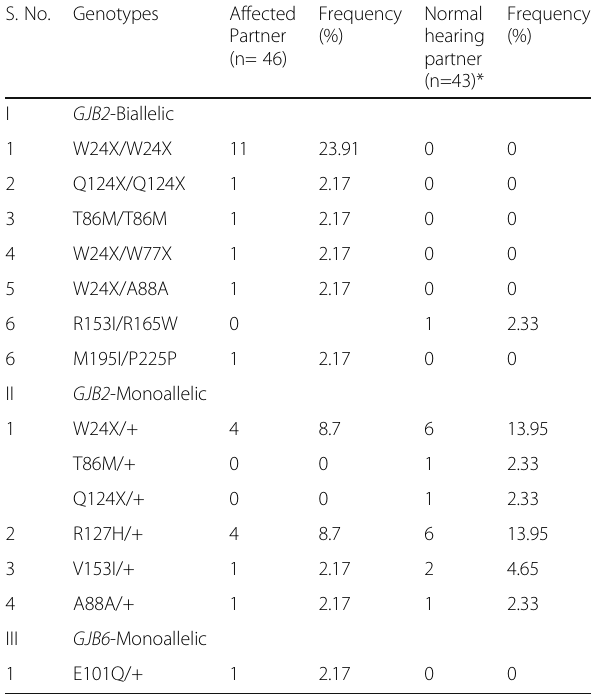
Table 9 Frequency and distribution of GJB2 and GJB6 genotypes observed among the mates of DXN mating S. No. Genotypes